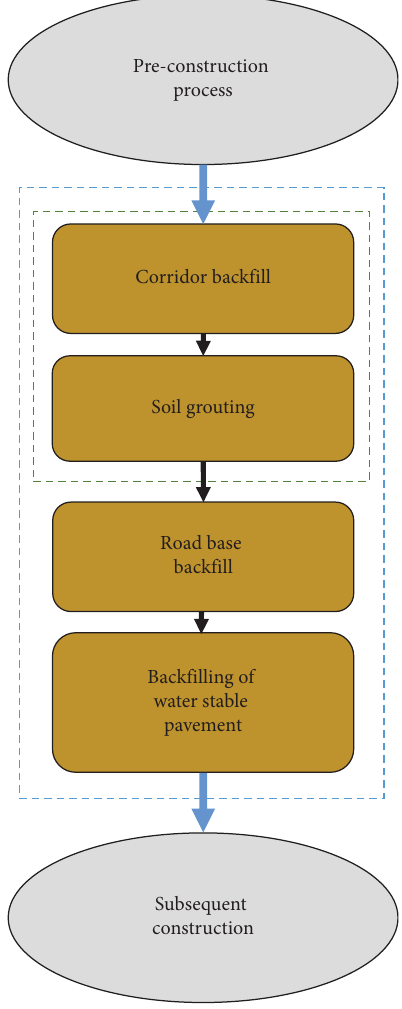
Figure 3: Construction scheme for the river-crossing section of the utility